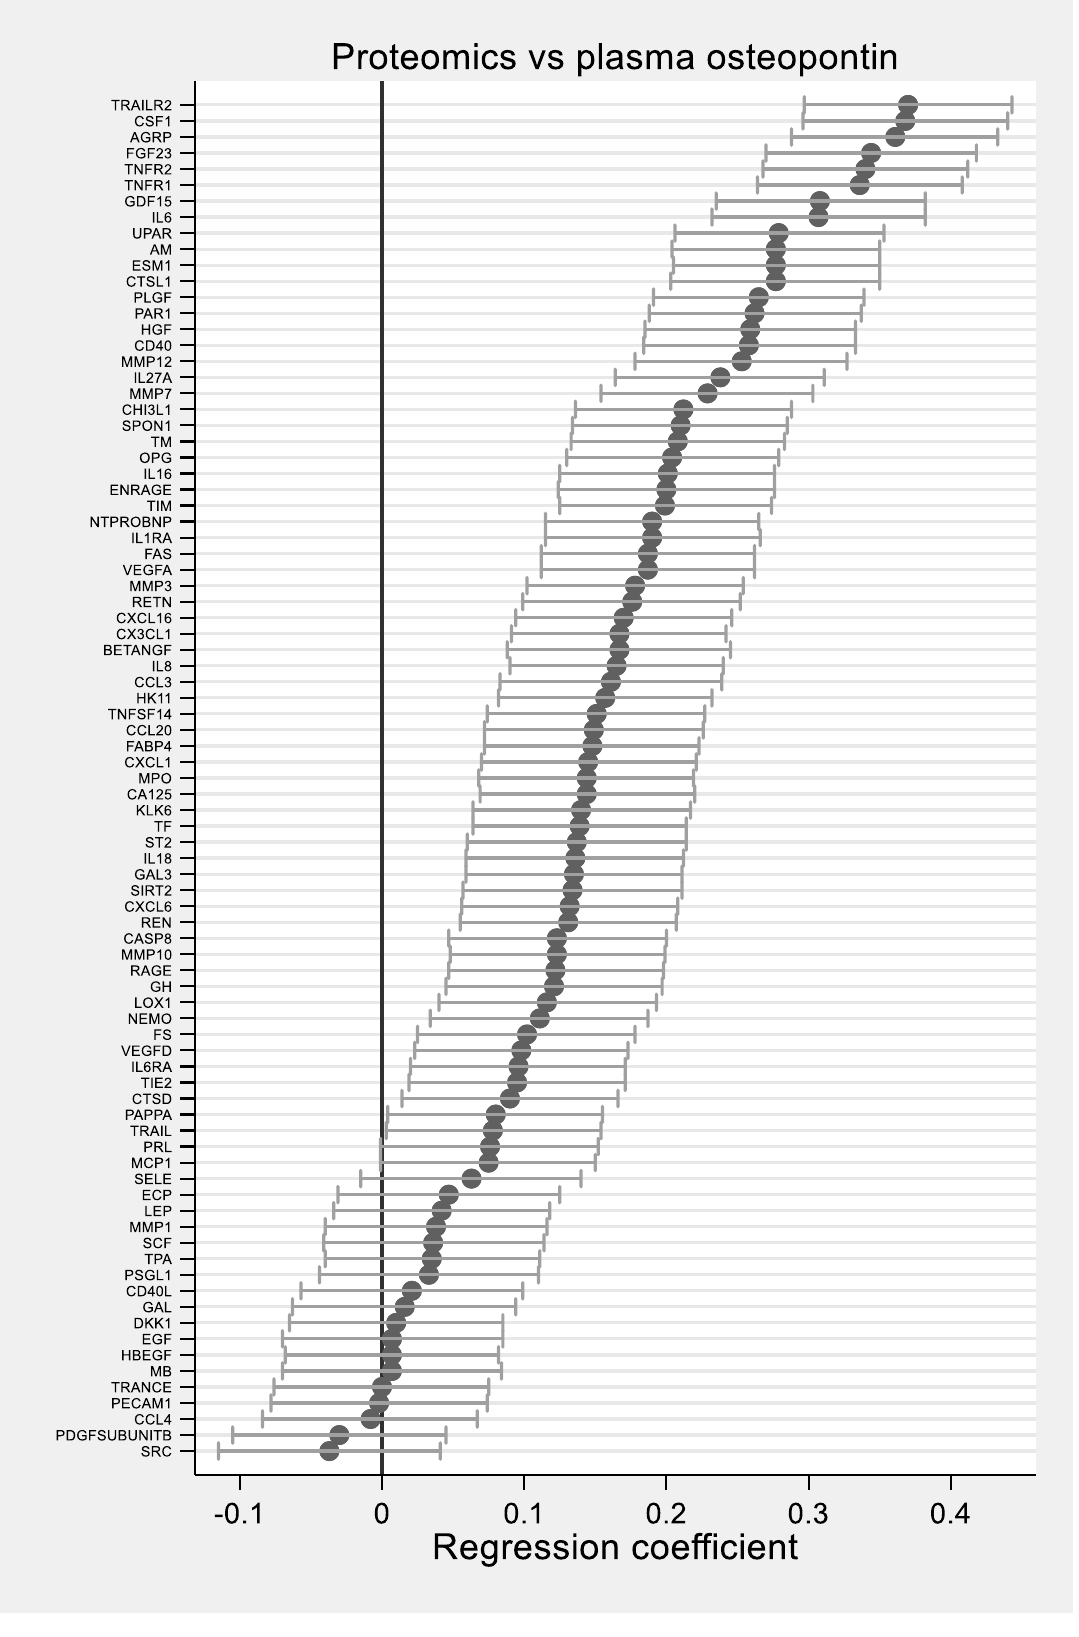
Figure 1. Forest plot showing the associations between plasma osteopontin and 85 biomarkers from the Proseek panel adjusted for age. Data are regression coefficients expressed per SD increase and 95% confidence